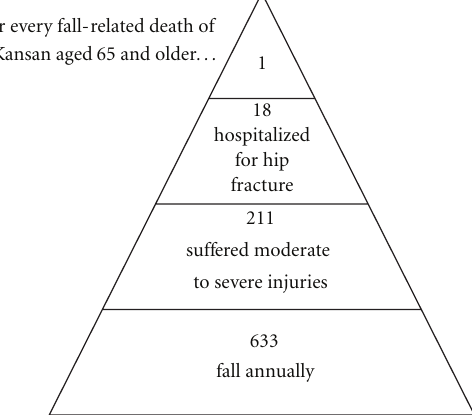
Figure 1: Falls and fall injuries of Kansas adults aged 65 and older, Kansas Health Statistics Report, February 2007. Figure 1 adapted from Figure 8, “ Falls and fall injuries among Michigan’s older adults, ” Michigan Department of Community Health, October